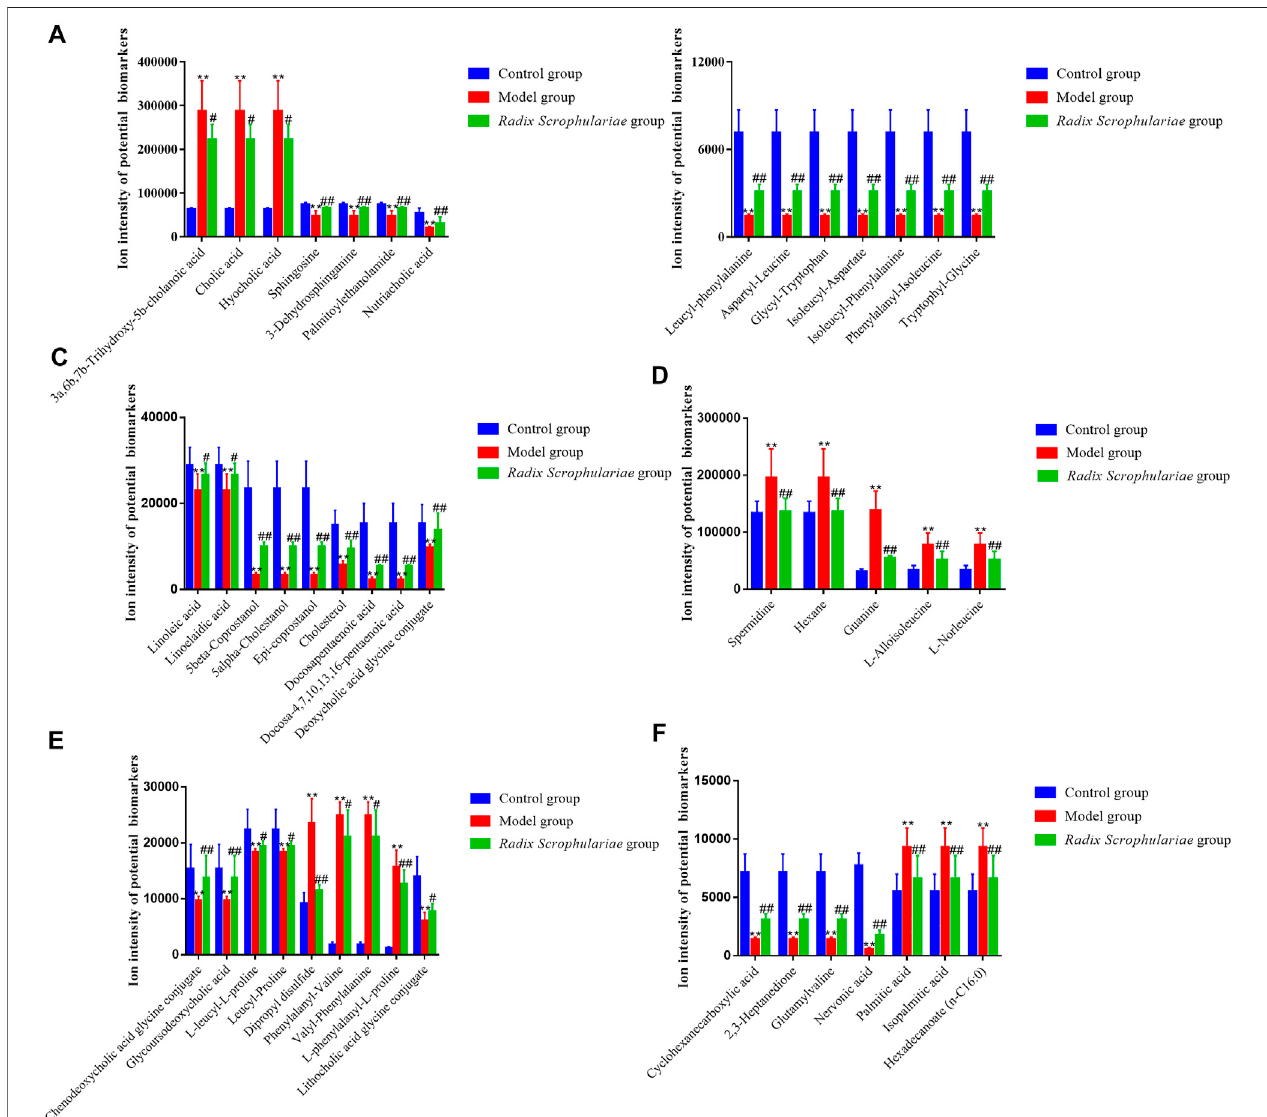
FIGURE3| Ionintensitiesofpotentialbiomarkersinfecalsamplesfromthedifferentgroups (A – F) .Thedataarepresentedasthemeans ± SEsfromeachgroup(n (cid:1) 10 in each group). *Altered trend compared with the Control group, p < 0.05; **altered trend compared with the control group, p < 0.01.